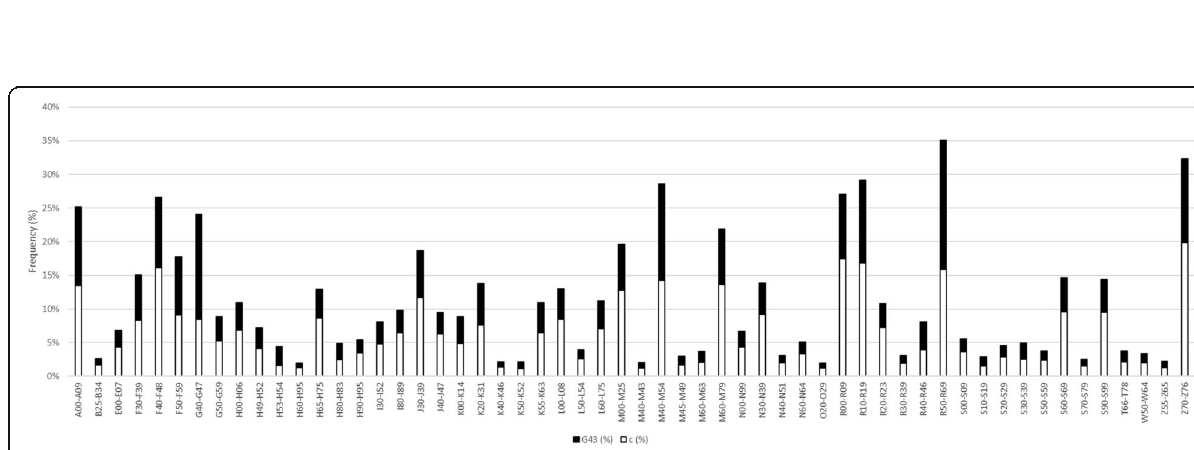
Fig. 6 Overall prevalence (%) of diagnoses with > 2% prevalence in migraine patients with over 1.5-fold increase in migraine patients (black) compared to controls (white), p < 0.001 for all ICD-10 blocks. Bars are superimposed on each other. A00-A09 Intestinal infectious diseases, B25-B34 Other viral diseases, E00-E07 Disorders of thyroid gland, F30-F39 Mood [affective] disorders, F40-F48 Neurotic, stress-related and somatoform disorders, F50-F59 Behavioural syndromes associated with physiological disturbances and physical factors, G40-G47 Episodic and paroxysmal disorders, G50-G59 Nerve, nerve root and plexus disorders, H00-H06 Disorders of eyelid, lacrimal system and orbit, H49-H52 Disorders of ocular muscles, binocular movement, accommodation and refraction, H53-H54 Visual disturbances and blindness, H60-H95 Diseases of the ear and mastoid process, H65-H75 Diseases of middle ear and mastoid, H80-H83 Diseases of inner ear, H90-H95 Other disorders of ear, I30-I52 Other forms of heart disease, I80-I89 Diseases of veins, lymphatic vessels and lymph nodes, not elsewhere classified, J30-J39 Other diseases of upper respiratory tract, J40-J47 Chronic lower respiratory diseases, K00-K14 Diseases of oral cavity, salivary glands and jaws, K20-K31 Diseases of oesophagus, stomach and duodenum, K40-K46 Hernia, K55-K63 Other diseases of intestines, L00-L08 Infections of the skin and subcutaneous tissue, K50-K52 Noninfective enteritis and colitis, L50-L54 Urticaria and erythema, L60-L75 Disorders of skin appendages, M00-M25 Arthropathies, M40-M43 Deforming dorsopathies, M40-M54 Dorsopathies, M45-M49 Spondylopathies, M60-M63 Disorders of muscles, M60-M79 Soft tissue disorders, N00-N99 Diseases of the genitourinary system, N30-N39 Other diseases of urinary system, N40-N51 Diseases of male genital organs, N60-N64 Disorders of breast, R00-R09 Symptoms and signs involving the circulatory and respiratory systems, O20-O29 Other maternal disorders predominantly related to pregnancy, R10-R19 Symptoms and signs involving the digestive system and abdomen, R20-R23 Symptoms and signs involving the skin and subcutaneous tissue, R30-R39 Symptoms and signs involving the urinary system, R40-R46 Symptoms and signs involving cognition, perception, emotional state and behaviour, R50-R69 General symptoms and signs, S00-S09 Injuries to the head, S10-S19 Injuries to the neck, S20-S29 Injuries to the thorax, S30-S39 Injuries to the abdomen, lower back, lumbar spine and pelvis, S50-S59 Injuries to the elbow and forearm, S60-S69 Injuries to the wrist and hand, S70-S79 Injuries to the hip and thigh, S90-S99 Injuries to the ankle and foot, T66-T78 Other and unspecified effects of external causes, W50-W64 Exposure to animate mechanical forces, Z55-Z65 Persons with potential health hazards related to socioeconomic and psychosocial circumstances, Z70-Z76 Persons encountering health services in other